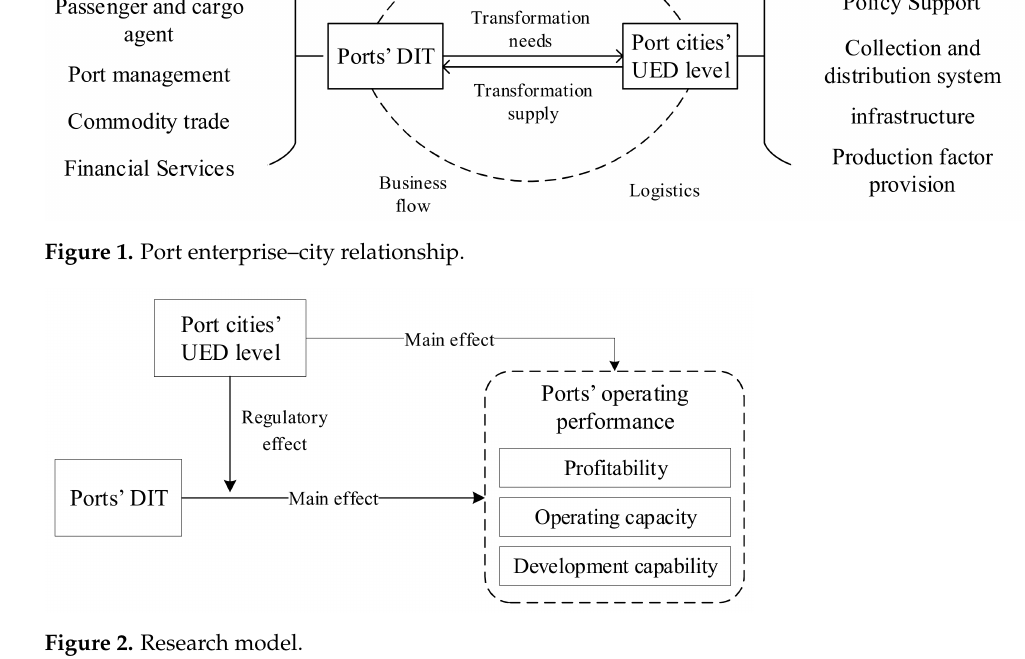
Figure 2. Research